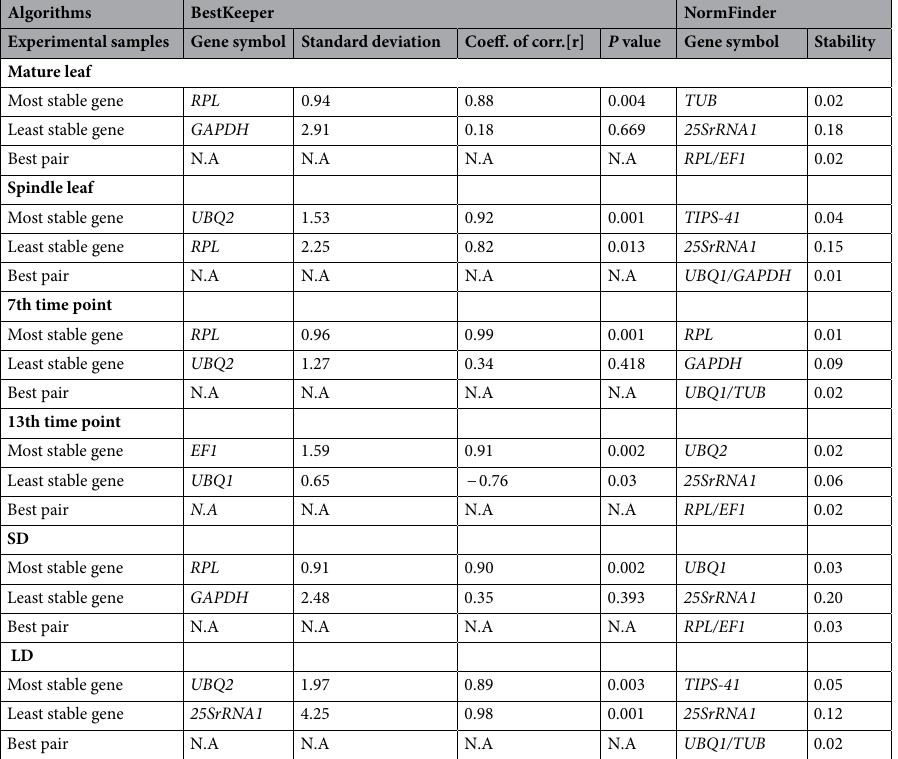
Table 3. Summarized data of the reference genes highlighted by the NormFinder and BestKeeper algorithms in different experimental samples. N.A Not applied to this algorithm. Complete data is available in Supplementary Table S2 online. Coeff.of corr. [r] stands for Pearson correlation between Bestkeeper index and candidate reference genes.